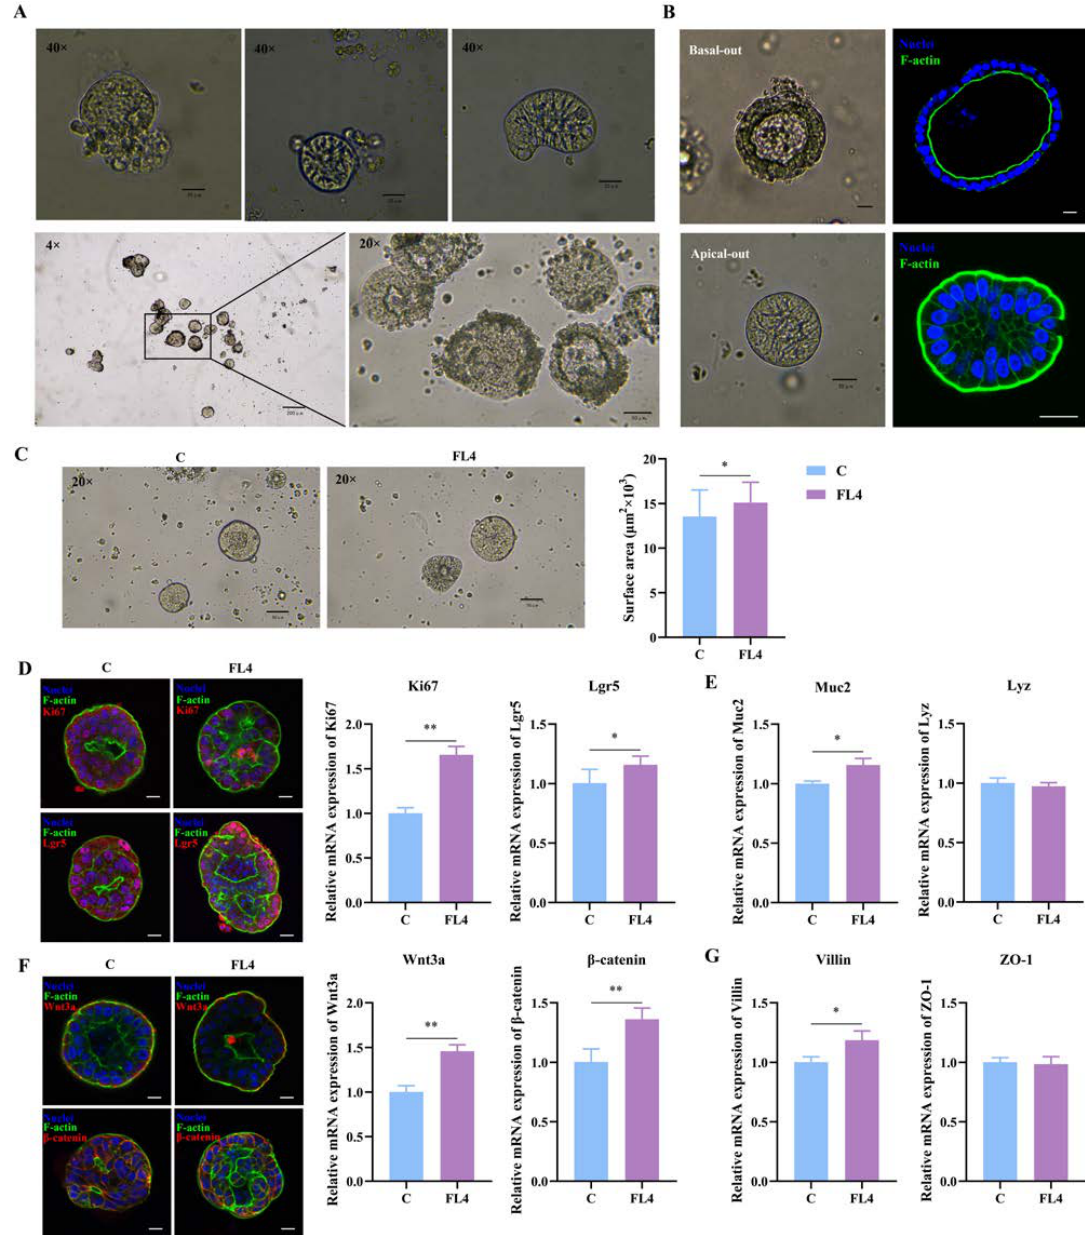
Figure 7. The establishment of apical-out intestinal organoids and the effects of L. fermentum FL4. ( A ) The procedure for polarity reversal of basal-out organoids to apical-out organoids and the shape of mature organoids. 4 × , scale bars, 200 µ m; 20 × , scale bars, 50 µ m; 40 × , scale bars, 20 µ m. ( B ) Contrast of organoid with basal-out polarity embedded in Matrigel or apical-out polarity in suspension depicted by micrographs (left) and confocal immunofluorescence images (right). Scale bars, 20 µ m. ( C ) Organoids were treated with or without L. fermentum FL4 (10 6 CFU/well) for 24 h. The surface area of organoids was calculated. 10 × , scale bars, 200 µ m; n = 6. ( D ) Confocal images of organoid staining with Nuclei (blue), F-actin (green), Ki67 and Lgr5 (red); scale bars, 20 µ m. RT-qPCR analysis of the Ki67 and Lgr5 in organoids treated with/without FL4; n = 3. ( E ) RT-qPCR analysis of the Muc2, lysozyme (Lyz) in organoids treated with/without FL4; n = 3. ( F ) Confocal images of organoid staining with Wnt3a and β -catenin (red); scale bars, 20 µ m. RT-qPCR analysis of the Wnt3a and β -catenin in organoids treated with/without FL4; n = 3. ( G ) RT-qPCR analysis of the villin and ZO-1 in organoids treated with/without FL4; n = 3. * p < 0.05, ** p <